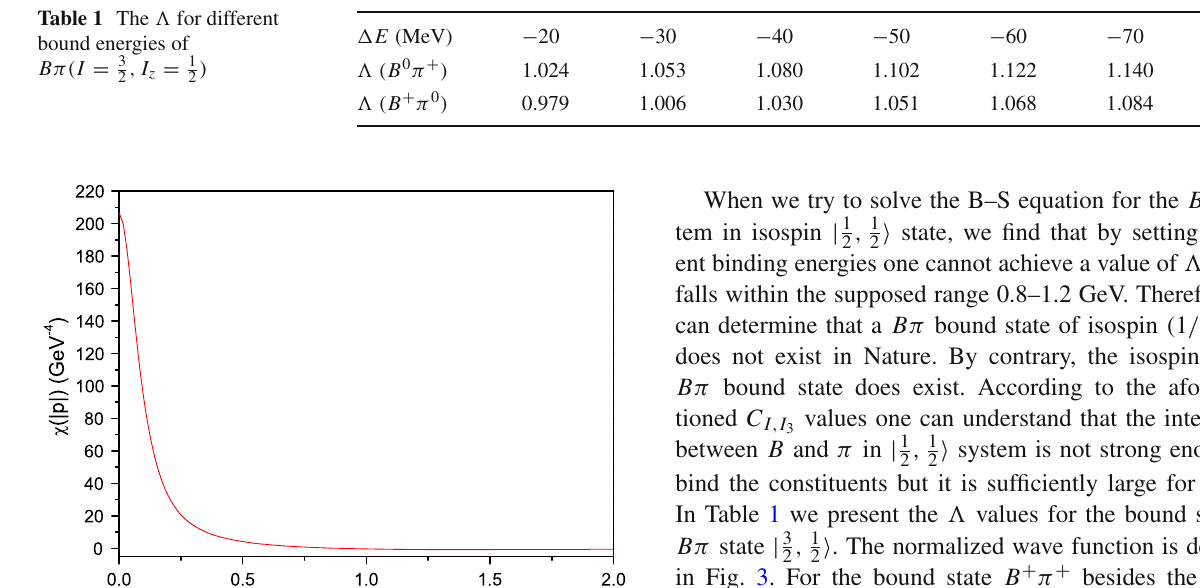
Table 1 The (cid:2) for different bound energies of B π( I = 3